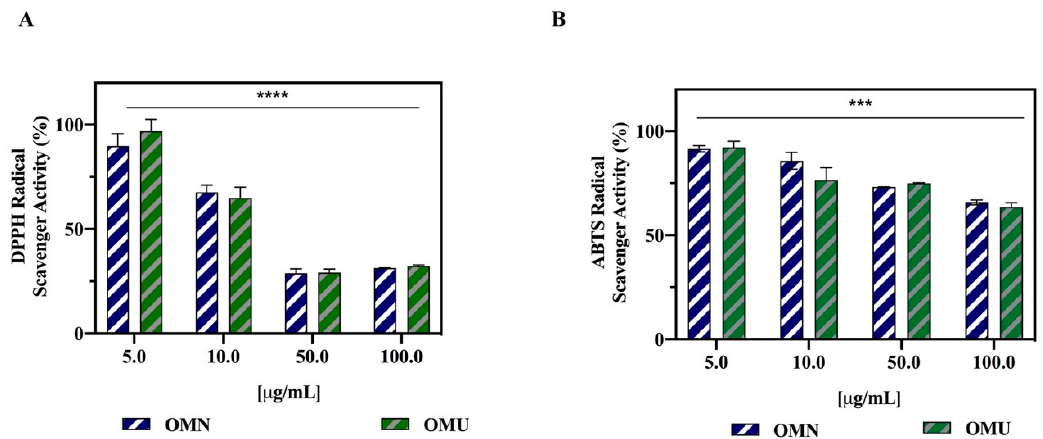
Figure 2. Antioxidant effects of OMN and OMU extracts. ( A ) In vitro radical scavenging activity of OMN and OMU phenol extracts by DPPH assay. ( B ) In vitro radical scavenging activity of OMN and OMU phenol extracts by ABTS assay. Data represent the mean ± s.d. of six determinations performed in triplicate. All the data sets have been analyzed by Two-way ANOVA. In particular, the reductions of DPPH (****) p < 0.0001 and ABTS (***) p < 0.001 radicals are significant as function of the concentrations, whereas no significant difference have been observed between OMN and OMU extracts.